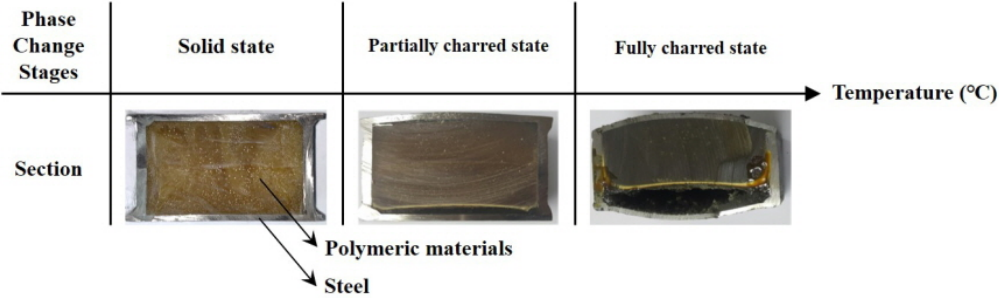
Figure 10. Three phase change stages at elevated temperatures.